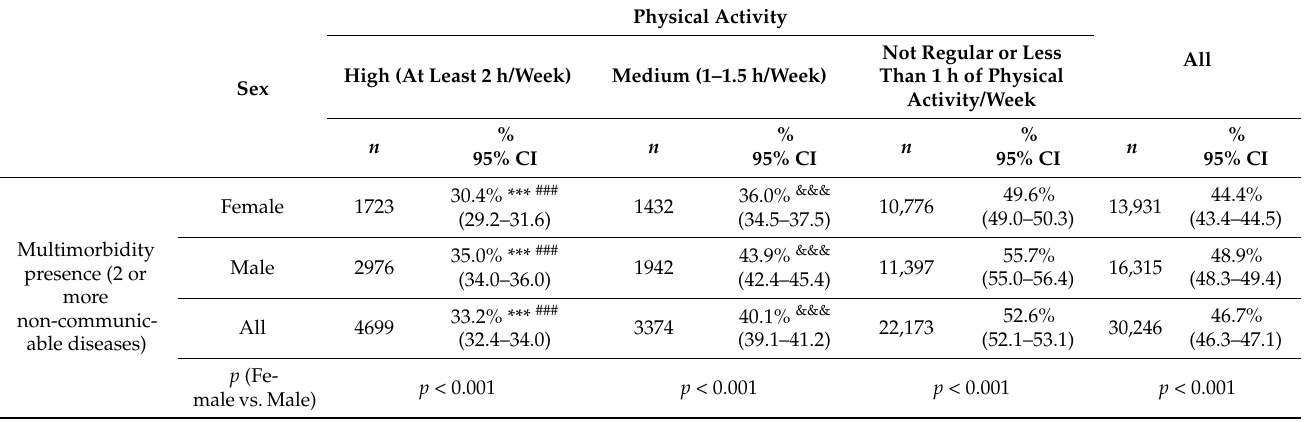
Table 8. Prevalence of